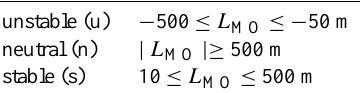
Figure 4. Comparison of the 30min mean wind speed between the WindScanner and a cup anemometer using two methods. Table 2. Classification of atmospheric stability according to Monin–Obukhov length